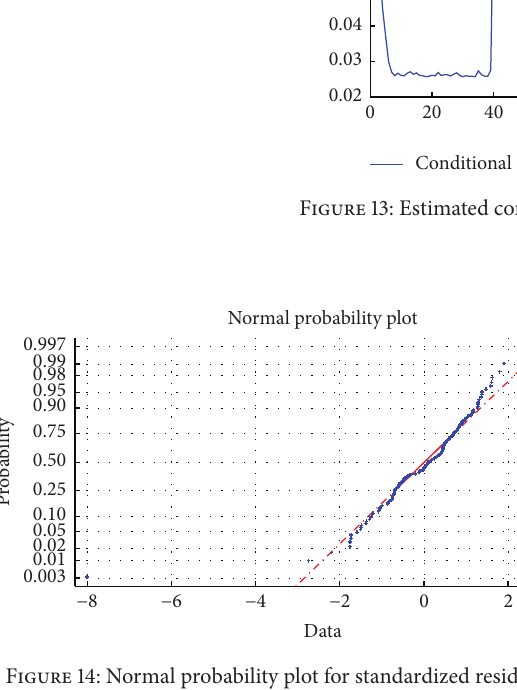
Figure 14: Normal probability plot for standardized